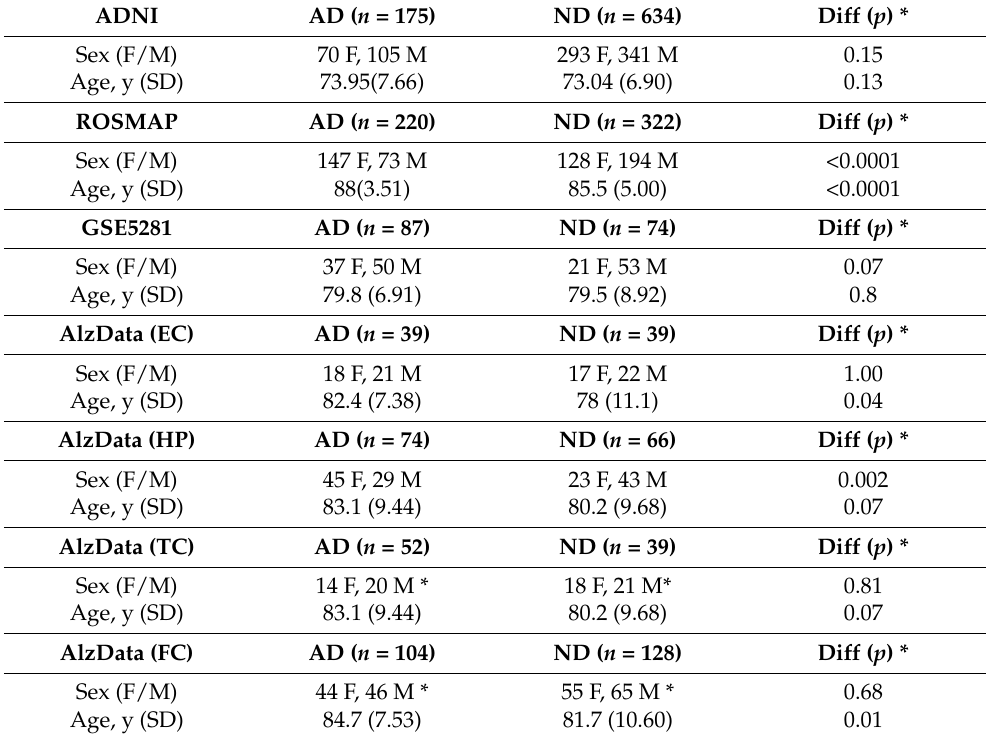
Table 1. Characteristics of study participants from ADNI mitochondrial genome cohort ( n = 809), ROSMAP ( n = 542), GSE5281 ( n = 161), and AlzData ( n =